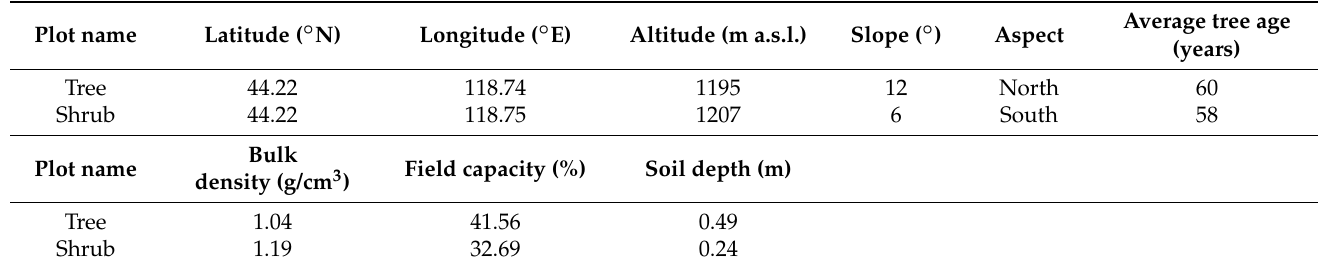
Table 1. Basic Information for the Quercus mongolica Tree and Shrub